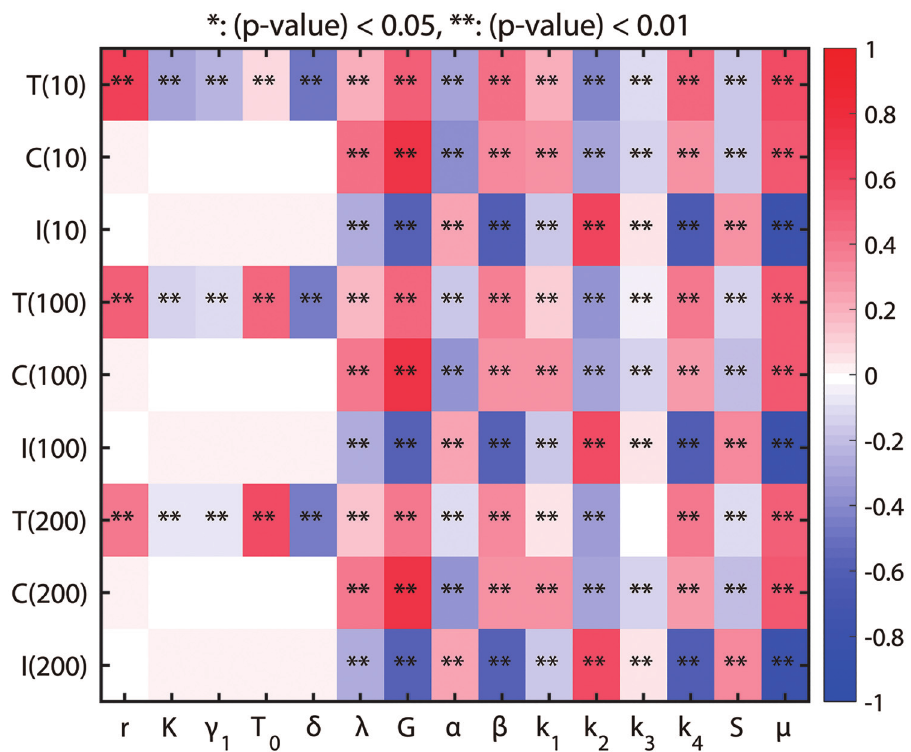
Fig 12. Sensitivity analysis: General Latin Hypercube Sampling (LHS) scheme and partial rank Correlation Coefficient (PRCC) performed on the model. The colors in each sub box indicates PRCC values of the N2 level and N1 activity for model parameters ( r , K , γ 1 , T 0 , δ , λ , G , S , k 1 , k 2 , k 3 , k 4 , α , β , μ ) at t = 10, 100, 200. The analysis was carried out using the method of [77] with sample size 10000.